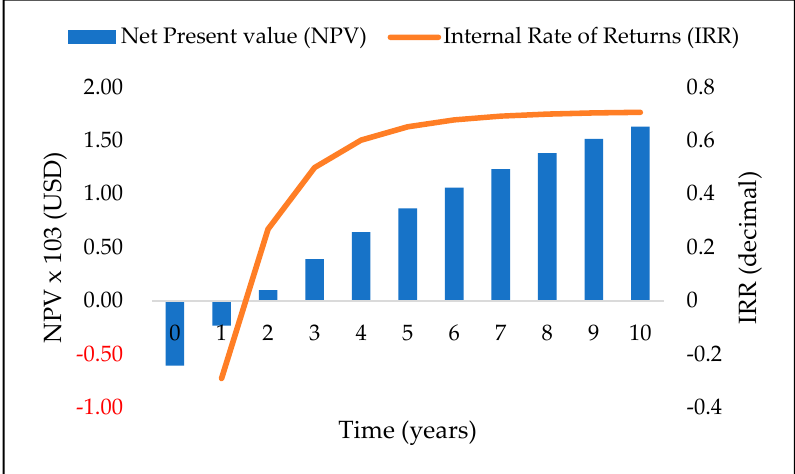
Figure 10. Variation of NPV and IRR over the 10-year operation period.